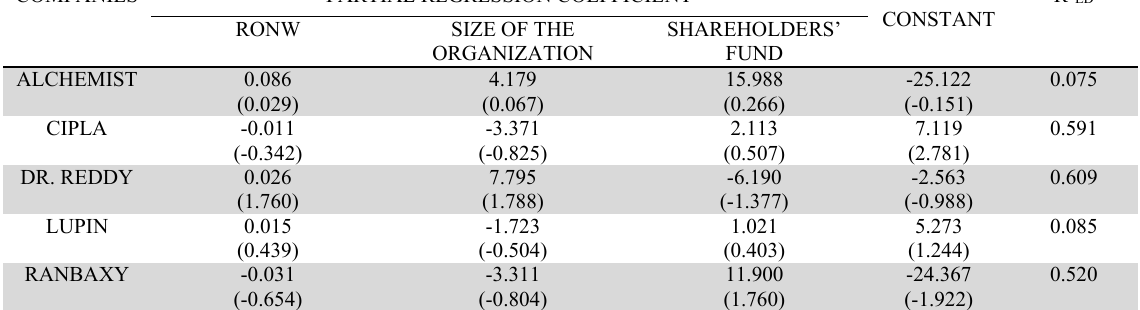
Analysis of Multiple Regression of CCC on RONW, Size of Org. and shareholders’ Fund of the Selected Companies of Pharmaceuticals Sector Regression Equation is CCC = a 0 +a 1 RONW+a 2 Size of Org.+a 3 Shareholders’